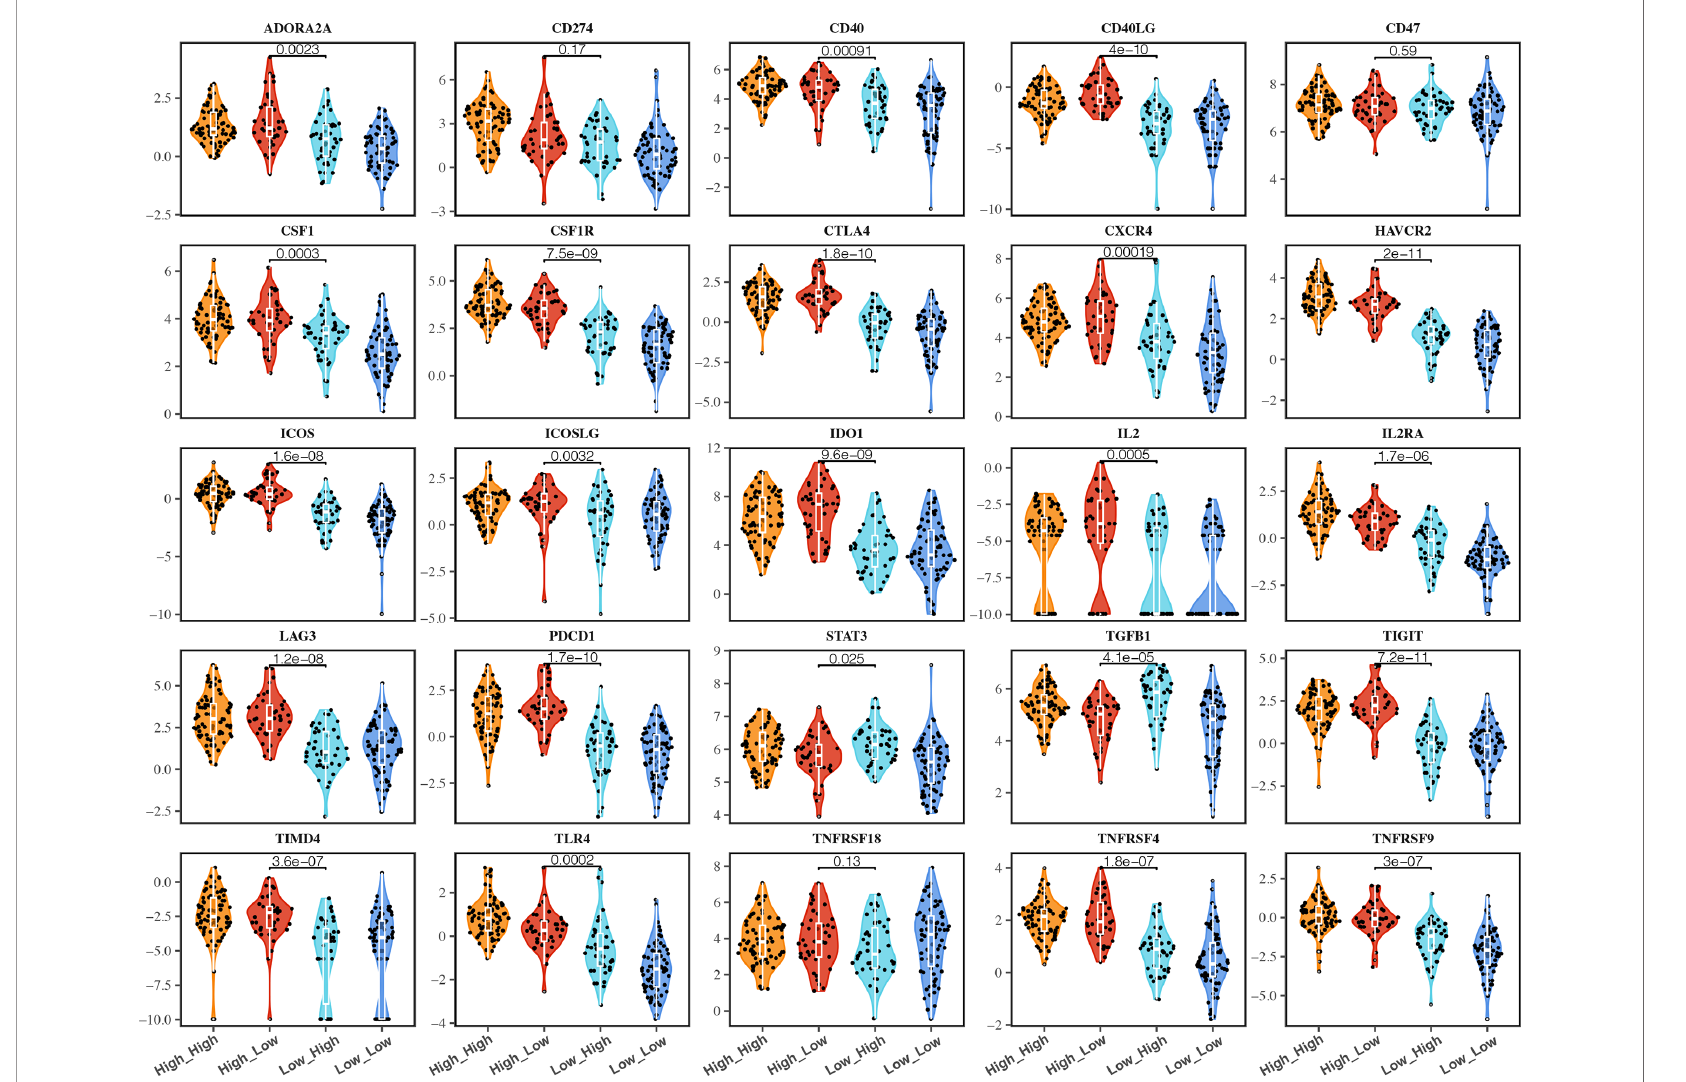
FIGURE 5 | Immune checkpoint molecules (ICMs) expressions in different groups of TCGA cervical cancer patients. Violin plots showing comparison of ICMs expressions among cervical cancer patients grouped by the gene signature expression of C1QC + TAM and SPP1 +